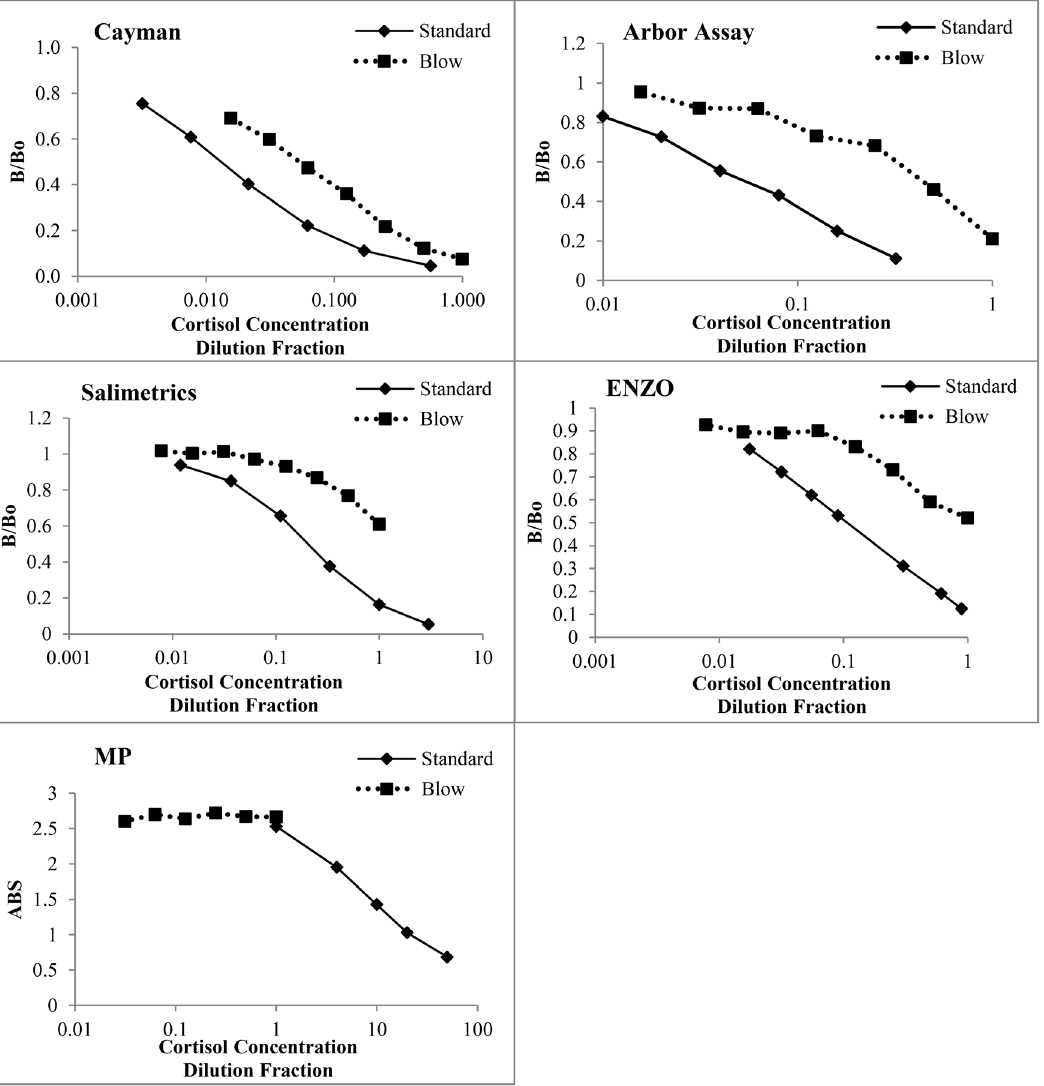
Figure 3. Parallelism results for pooled blow (n 5 3) for 5 commercial enzyme-immunoassay’s. The B/Bo could not be calculated for MP Biomedical due to differences in kit protocols, therefore absorbance values were used in this case. Cortisol concentration of standards or dilution factor of pooled samples are plotted on the x axes (Log